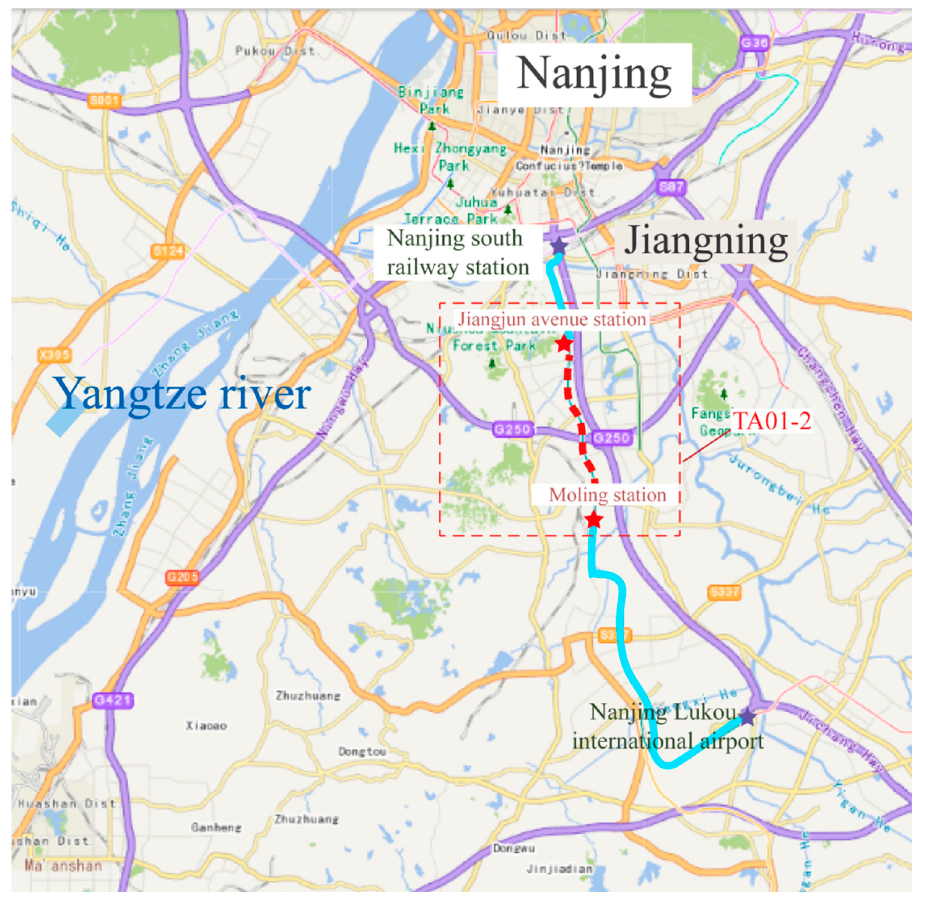
Figure 1. Project location.